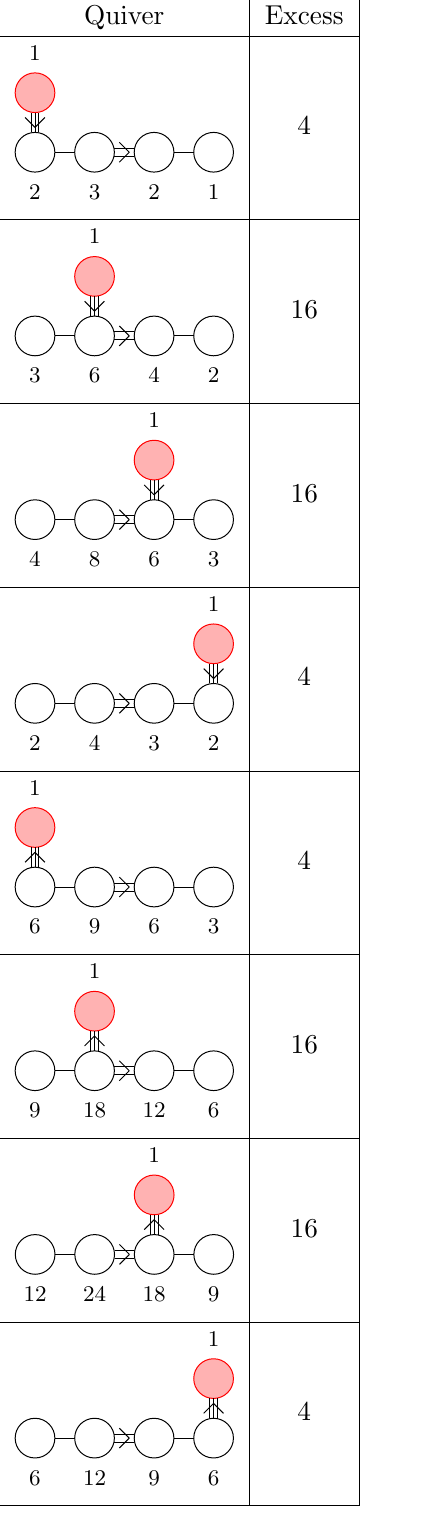
Table 33 . Exotic minimally unbalanced quivers with G = F 4 and an extra triple laced